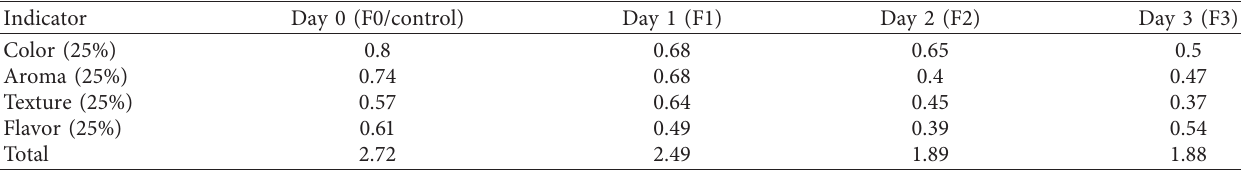
Table 7: Results of weighting hedonic test.